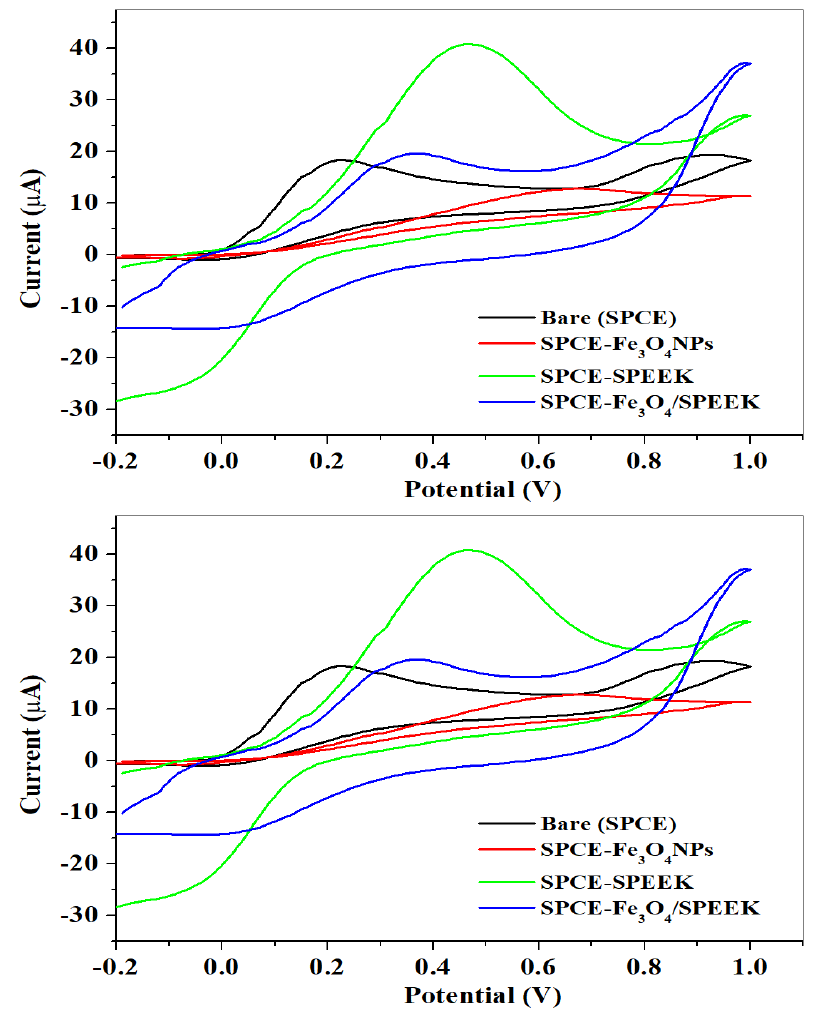
Figure 9. Comparative cyclic voltammogram of bare SPCE and modified electrodes in 0.1 M PBS (pH 7.4) containing 0.1 mM DA. Table 2. Summary of parameters obtained using cyclic voltammetry on bare and modified electrodes in 0.1 mM DA.